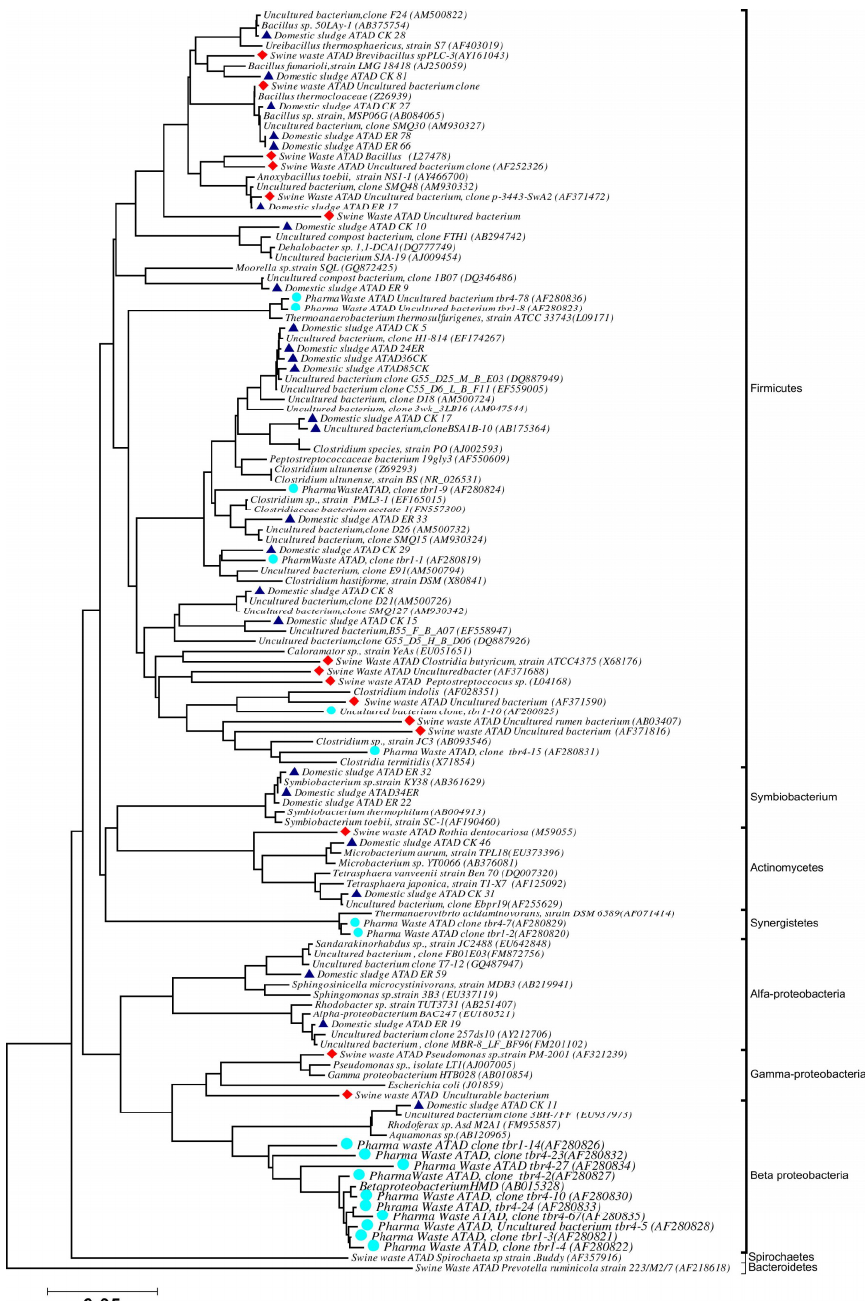
Figure 2. Phylogenetic positioning and evolutionary relationship of 16S rDNA clones and isolated strains obtained from ATAD reactors and their nearest neighbors Accession numbers of the sequences retrieved from GenBank are given together with their names. ATAD isolates from domestic waste [2] are illustrated with closed triangle (blue), isolates and clones from ATAD treated swine manure [21] (closed rectangular orange), isolates and clones form ATAD treated pharmaceutical waste (closed circle aquamarine) [17]. Bar scale represents 0.05 nucleotide substitutions per position. The evolutionary relationship was inferred using the neighbor-joining method, with evolutionary distances computed using the maximum composite likelihood method [53] and are in the units of number of base substitutions per site. Phylogenetic analyses were conducted in MEGA 4.0 [52]. Reproduced with permission from Water Research,